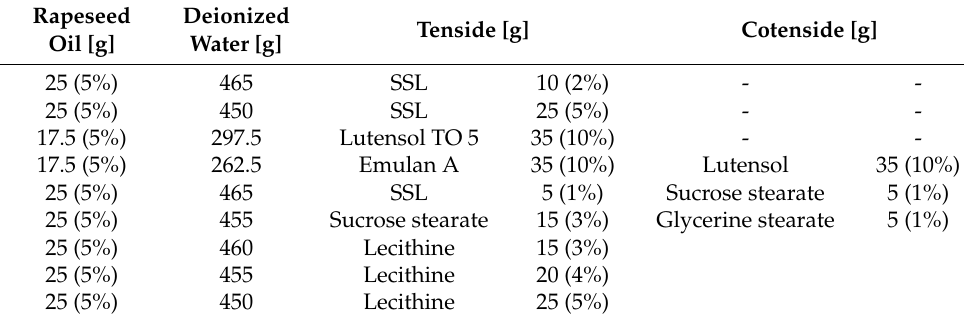
Table 2. Emulsions with stabilities in excess of 50